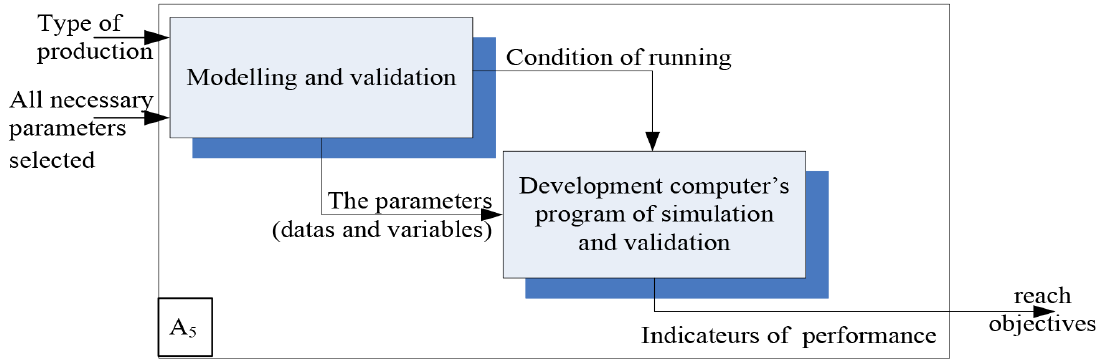
Figure 10. Activity A